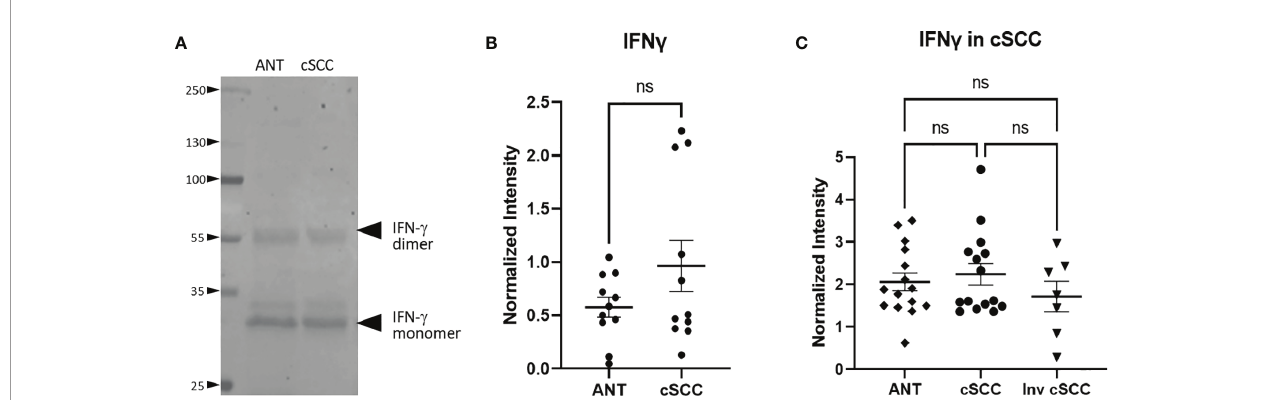
FIGURE 3 | IFN- g Expression in cSCC is Unchanged. Bands at the expected molecular weight for glycosylated IFN- g monomer and IFN- g dimer are detected at in both adjacent normal tissue and cSCC samples (A) . The ratio of intensity for both IFN- g bands in paired samples was normalized to histone H3 intensity and is not signi fi cant (ns) (B) . The ratio of intensity for both IFN- g bands in unpaired non-invasive and invasive cSCC samples normalized to GAPDH compared to control was also not signi fi cant (ns) (C) .